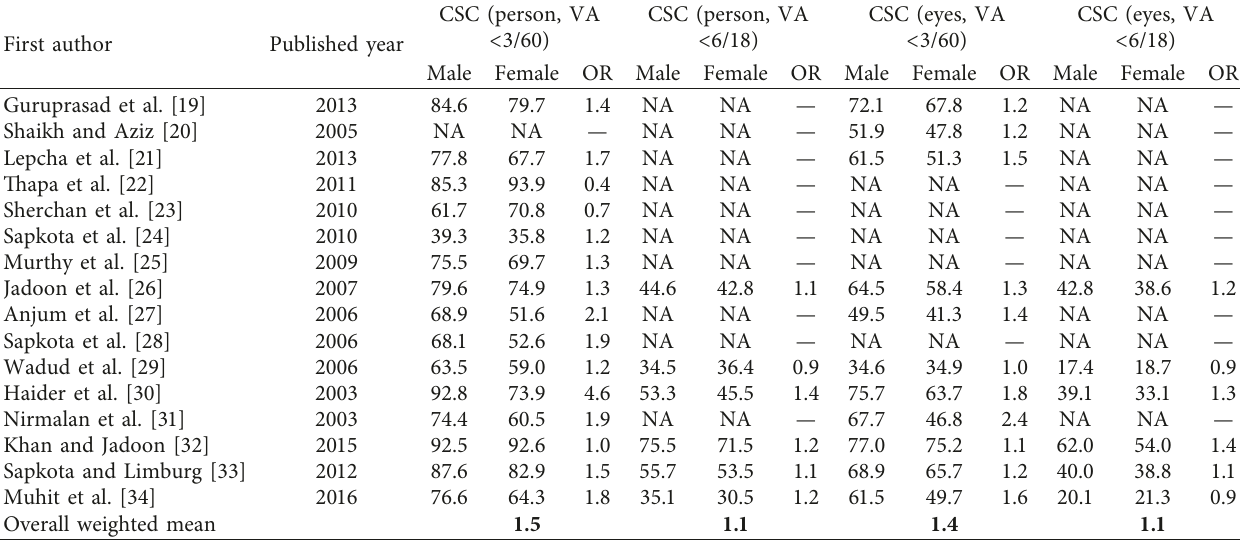
Table 3: Cataract surgical coverage (CSC) in male and female at different visual acuity level.